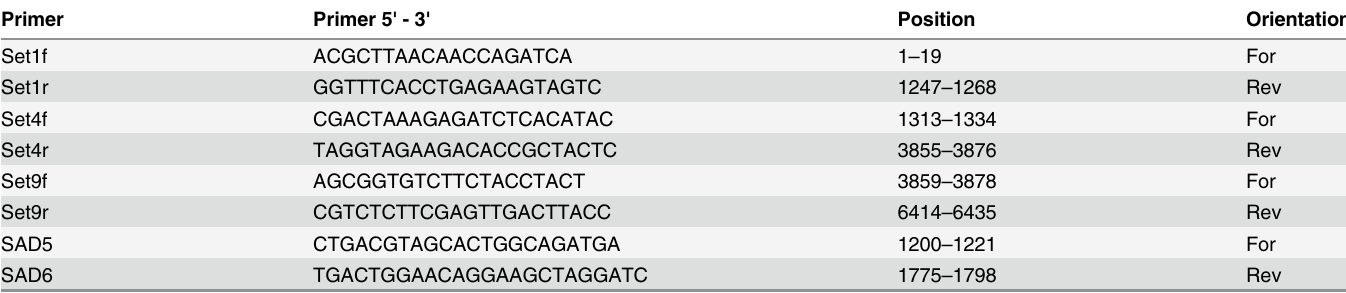
Table 1. Characteristics of primers used for the reverse transcription and PCR amplification of viral RNA prior to 454